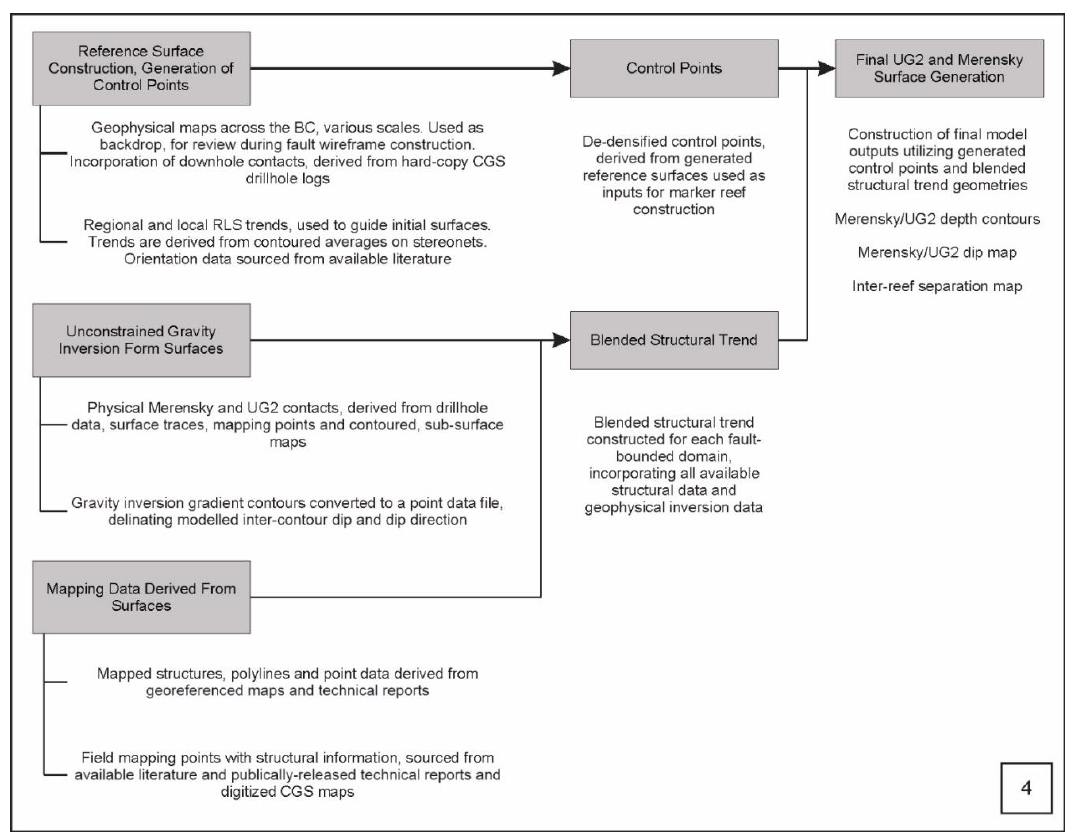
Figure 4. Schematic of modelling workflow, detailing key inputs used for the construction of the UG2 and Merensky Reef surfaces.